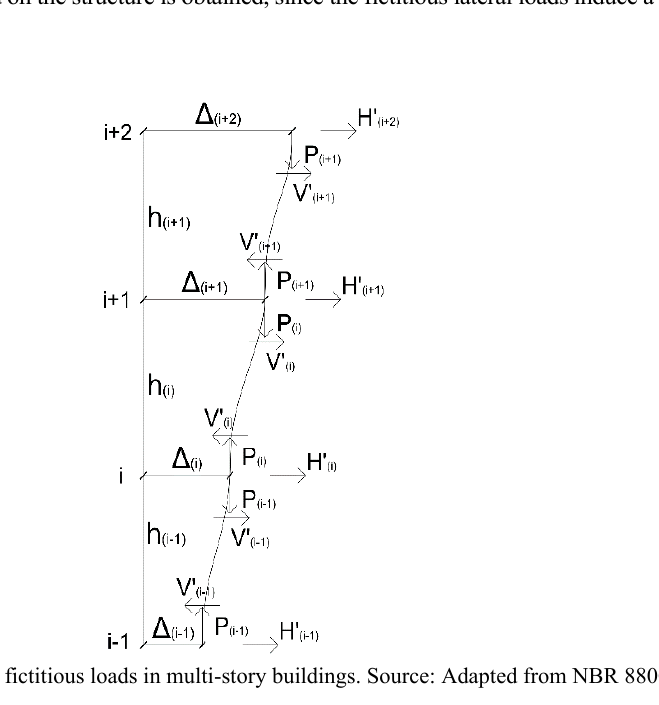
Every analysis in this method is first-order. Initially, horizontal displacements are calculated for each floor.